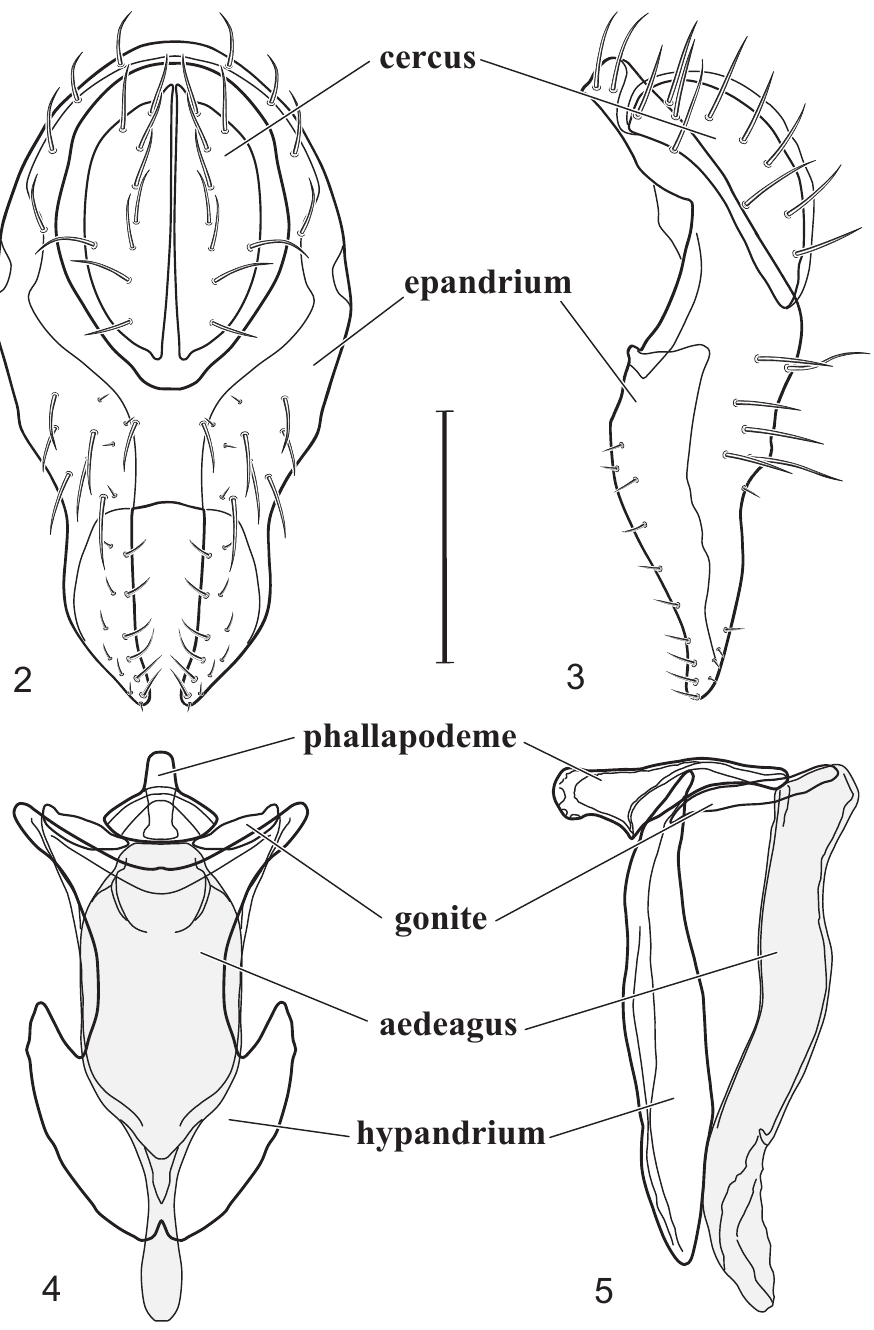
Figures 2–5. Hydrochasma castilloi sp. n. (Ecuador. Loja: Catamayo) 2 epandrium and cerci, posterior view 3 same, lateral view 4 internal structures of male terminalia (aedeagus [shaded], phallapodeme, gonite, hypandrium), ventral view 5 same, lateral view. Scale bar = 0.1